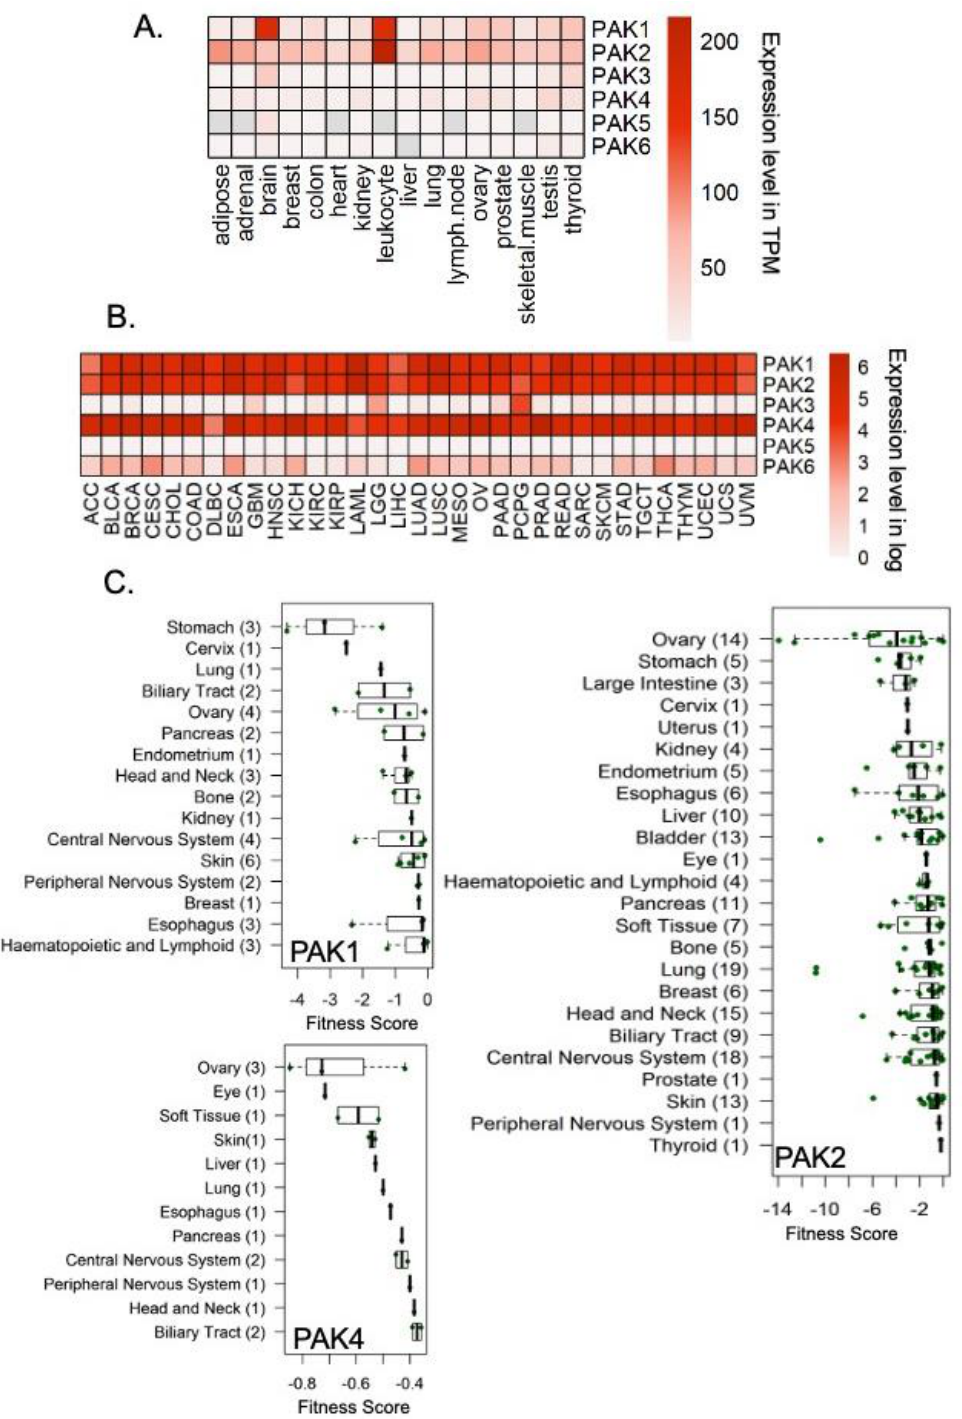
Figure 1. Expression of PAKs in normal tissues and human tissues. ( A ) Expression of PAK mRNAs in normal tissues using Illumina BodyMap data deposited in the EBI expression atlas database (E-MTAB-513); ( B ) Expression of PAK mRNAs in tumor tissue using TCGA dataset from GEPIA; ( C ) Status of PAK genes as fitness target genes with a significant dependency effect on the fitness of test cell lines upon knockdown of PAKs in different cancer cell lines in the Sanger Institute Cellular Dependency Dataset [27] Each dot, fitness value in one cell line; number in the bracket, number of cell lines.